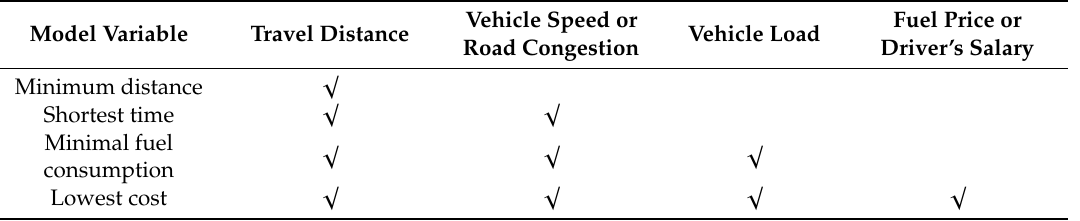
Table 2. Di ff erences among various models.